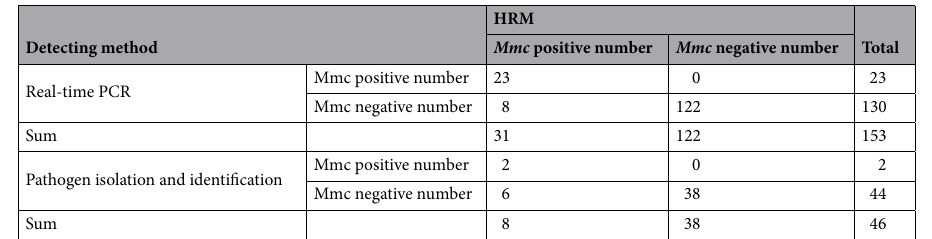
Table 3. Results of clinical samples with real-time PCR and HRM